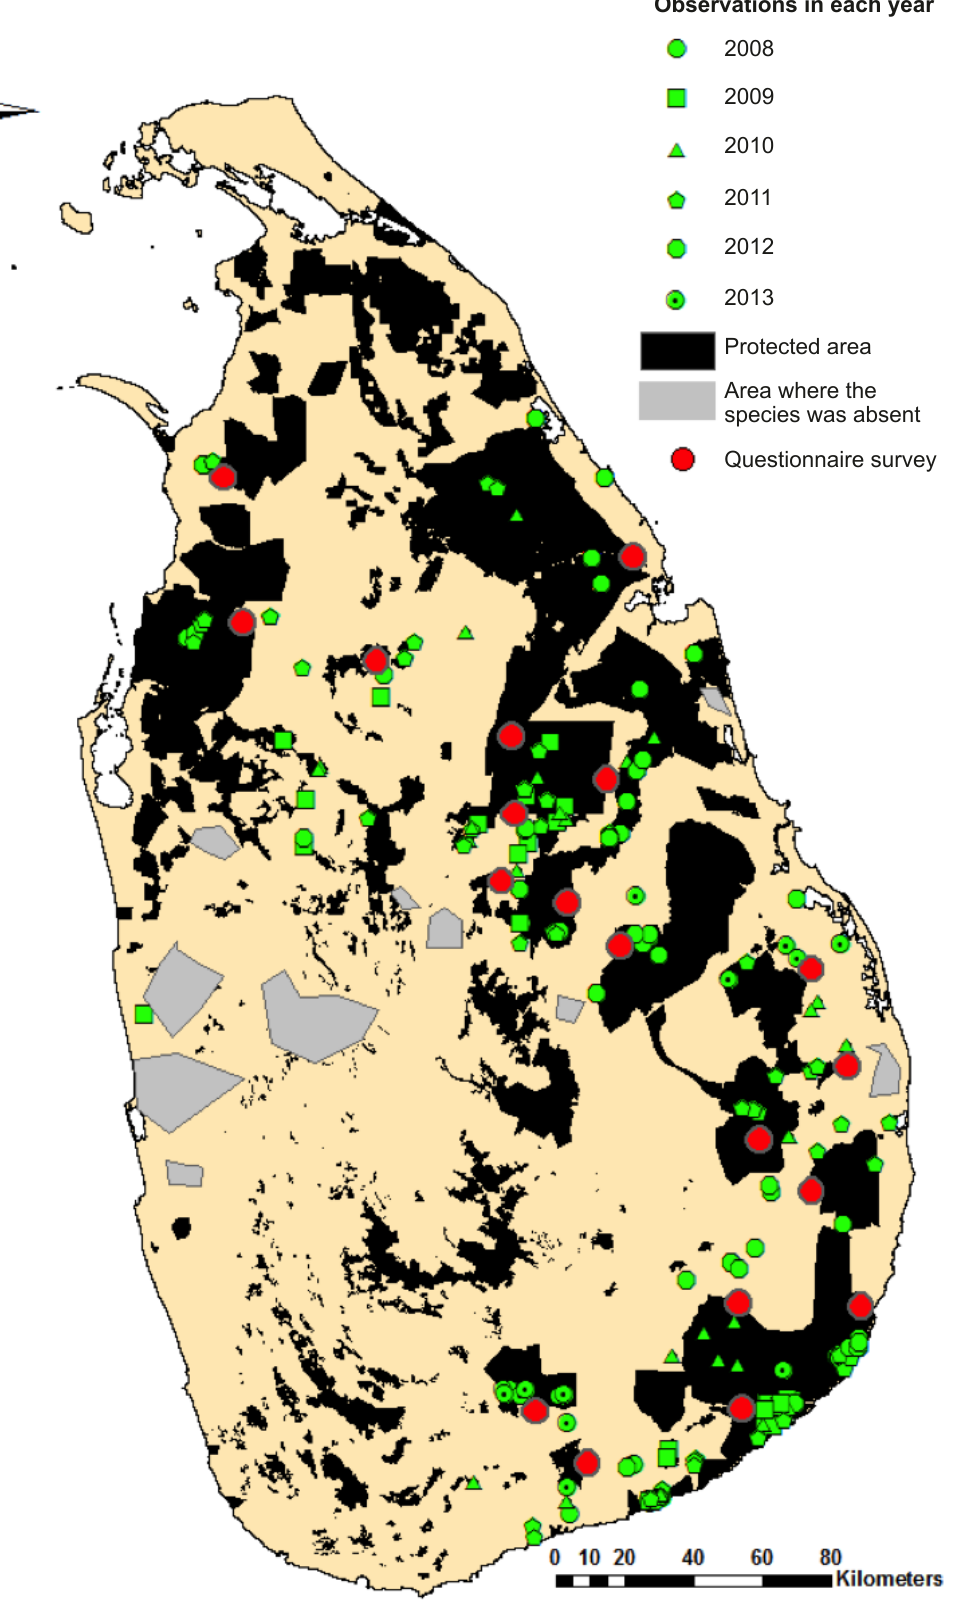
Figure 1. Distribution of Lesser Adjutant in Sri